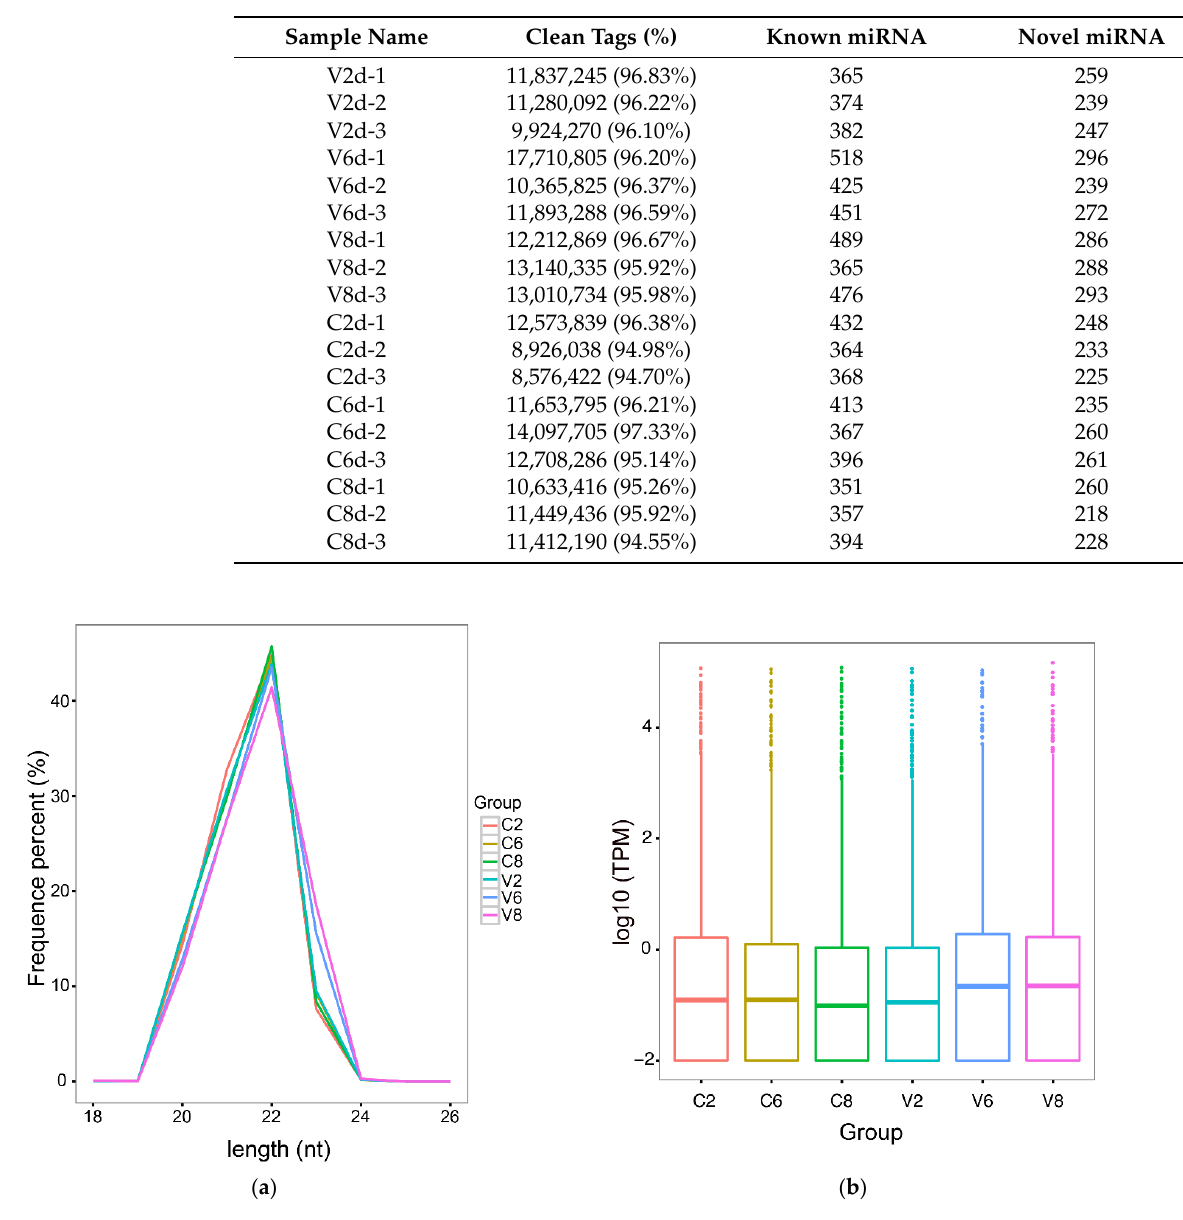
Table 1. Summary of miRNA sequencing of the 18 samples. V2d, V6d, and V8d represent megalocytivirus-infected fish at 2, 6, or 8 days post infection (dpi), respectively. C2d, C6d, and C8d represent control fish at 2, 6, or 8 dpi, respectively. For both virus-infected and control fish, at each time point, three fish were used (indicated by the number of 1, 2, or 3, e.g., V2d-1, V2d-2, and V2d-3).